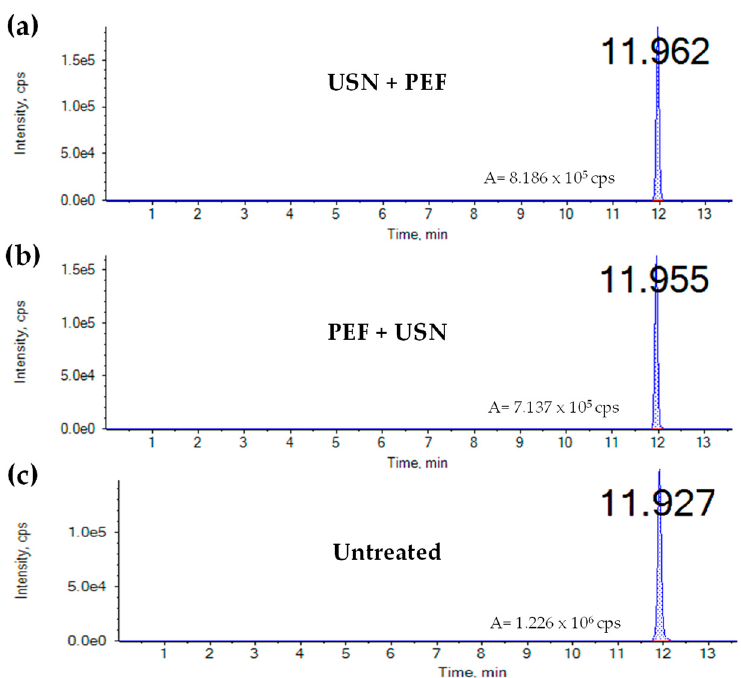
Figure 3. LC-MS/MS-IT chromatograms of orange juice with milk spiked by Enniatin B treated by PEF + USN ( a ) vs. treated by PEF + USN ( b ) vs. untreated ( c ). The area (A) and the retention time (min) also are indicated. USN: Ultrasounds, PEF: Pulsed Electric